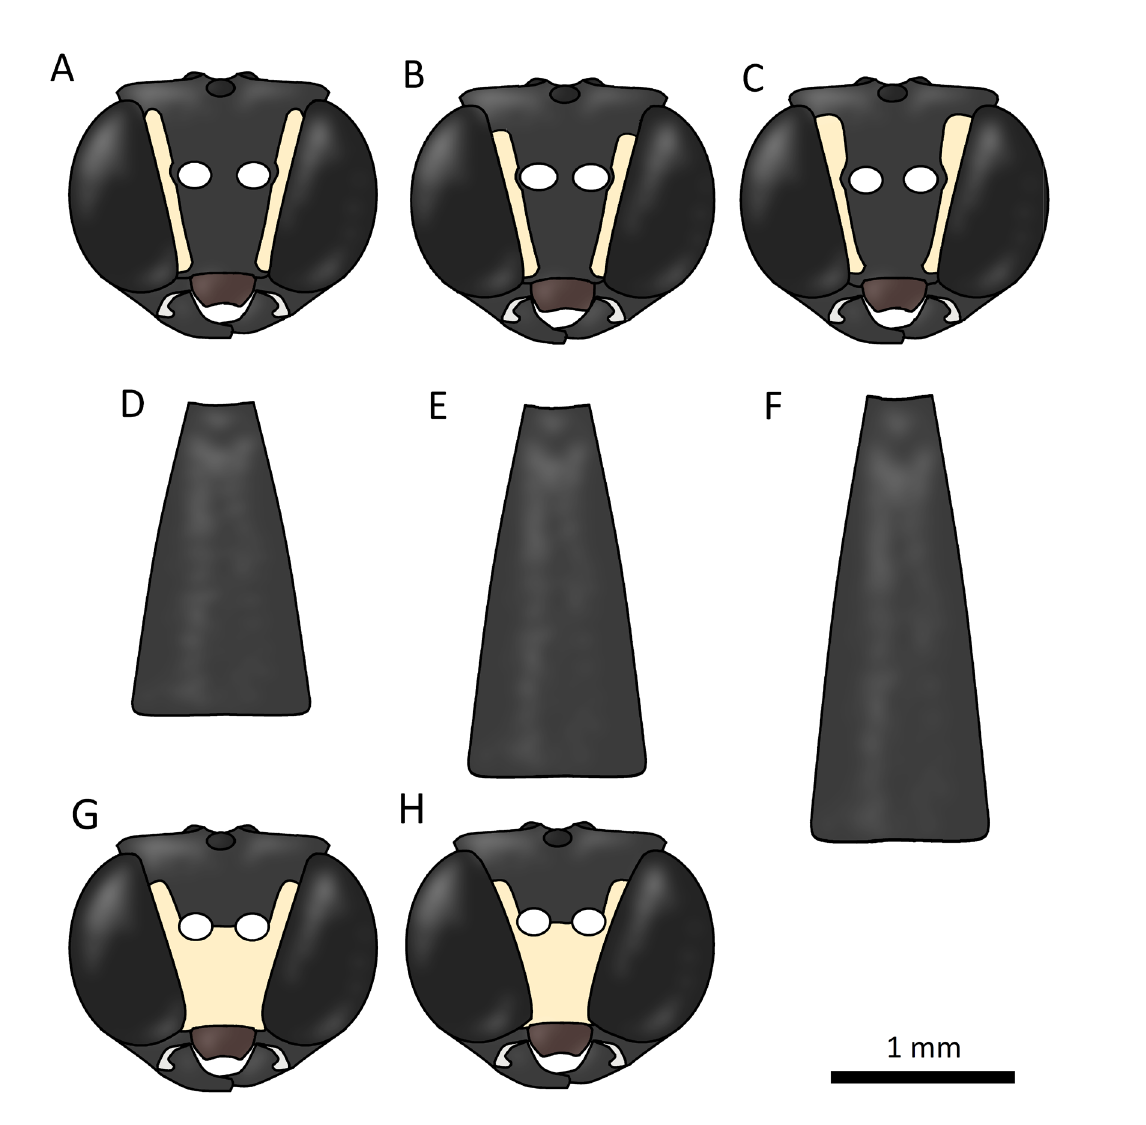
Fig. 9. A – C . ♀, generalized shape of head and colouration of face, anterior view. A . Neoxorides collaris (Gravenhorst, 1829). B . N. striatus Johansson sp. nov. (lectotype NHRS-HEVA000011623). C . N. montanus (Oehlke, 1966). D – F . ♀, generalized shape of first tergite, dorsal view. D . N. collaris . E . N. striatus Johansson sp. nov. (lectotype NHRS-HEVA000011623). F . N. montanus . G – H . ♂, generalized shape of head and colouration of face in anterior view. G . N. montanus . H . N. striatus Johansson sp. nov. (paratype